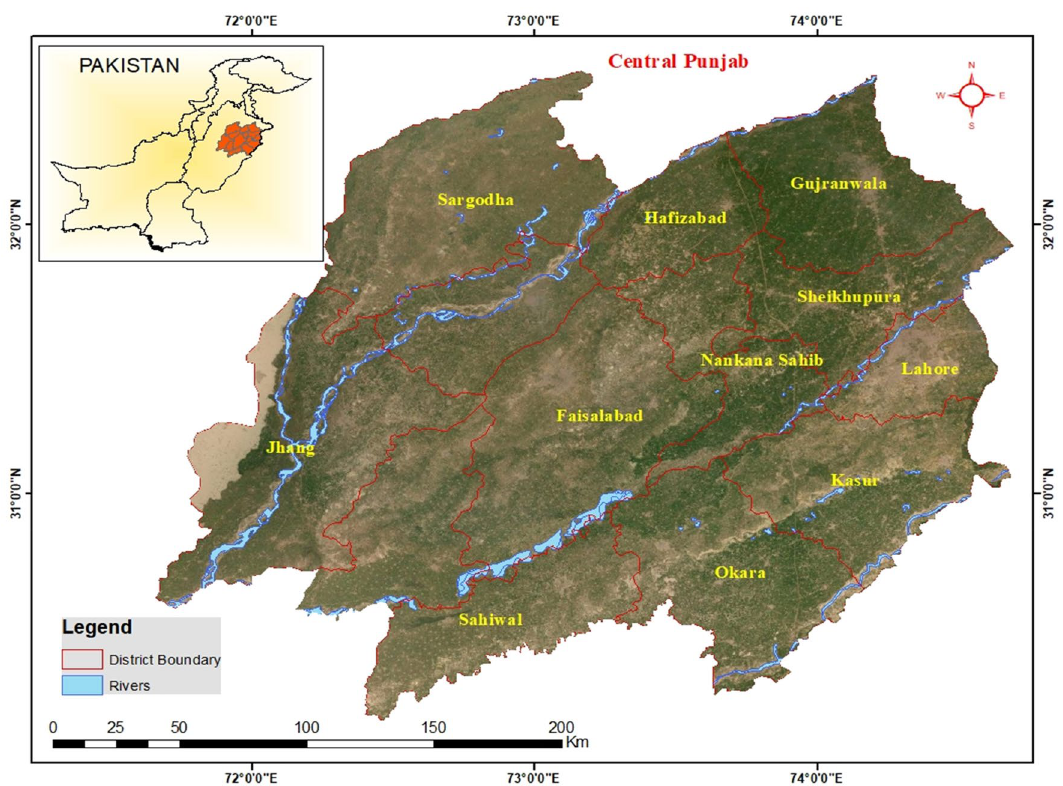
Figure 9. Illustration of sample collection sites i.e. Sargodha, Sialkot, Lahore, Gujranwala, Faisalabad, Okara, Sahiwal, Jhang, Sheikhupura, Nankanasab rcGIS version 10.8 software was to draw this map. Basemap is